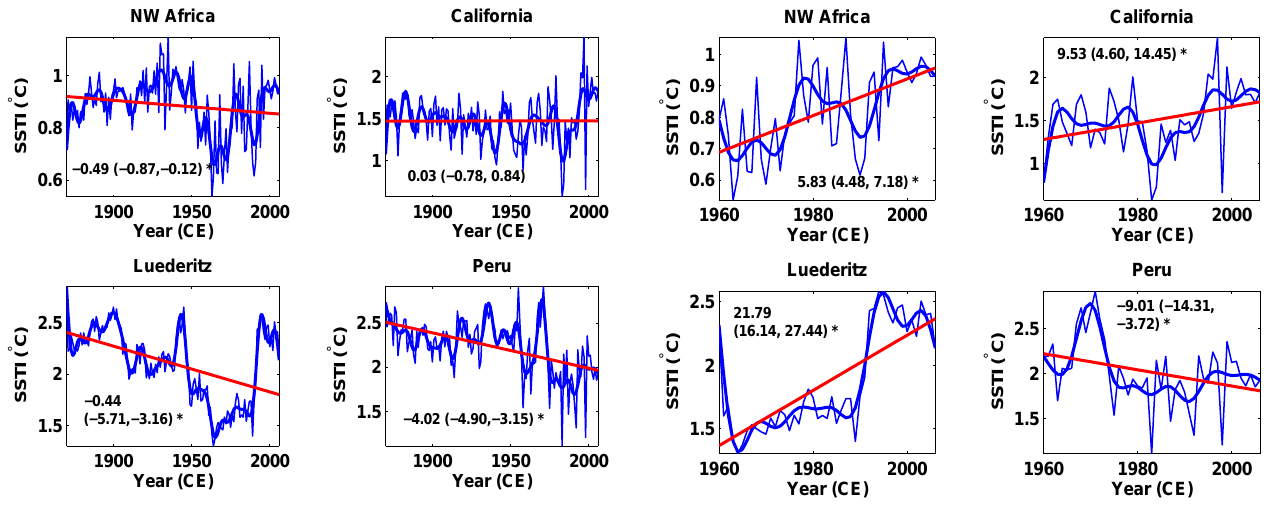
Fig. 6. Trends of coastal upwelling derived from the HadISST dataset (Rayner et al., 2003), for the period 1870–2006. Signif- icant decreasing trends are observed at NW Africa, L¨uderitz and Peru. The value of the slope and its 95% confidence interval are given in each panel (in units of 10 − 3 ◦ Cyr − 1 ). A ∗ indicates that the slope is statistically significant at the 0.05 level. Also shown are the unsmoothed time series (thin lines).